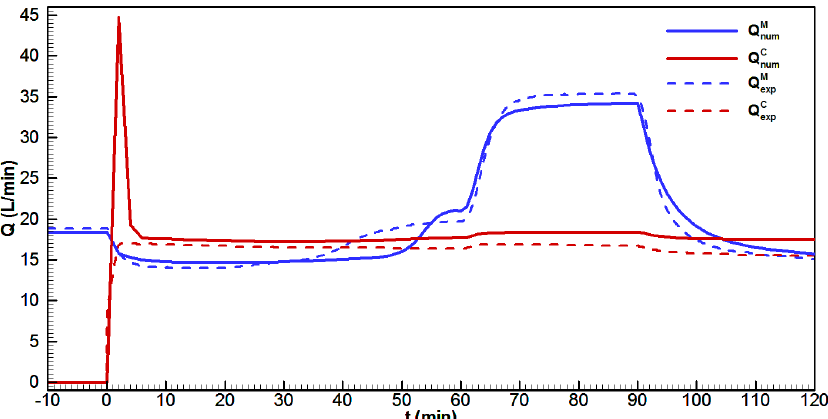
Figure 14. Hydrograph: Experimental (dashed line) results and numerical (solid line) results for matrix (M—blue line) and conduit discharge (C—red line), respectively.